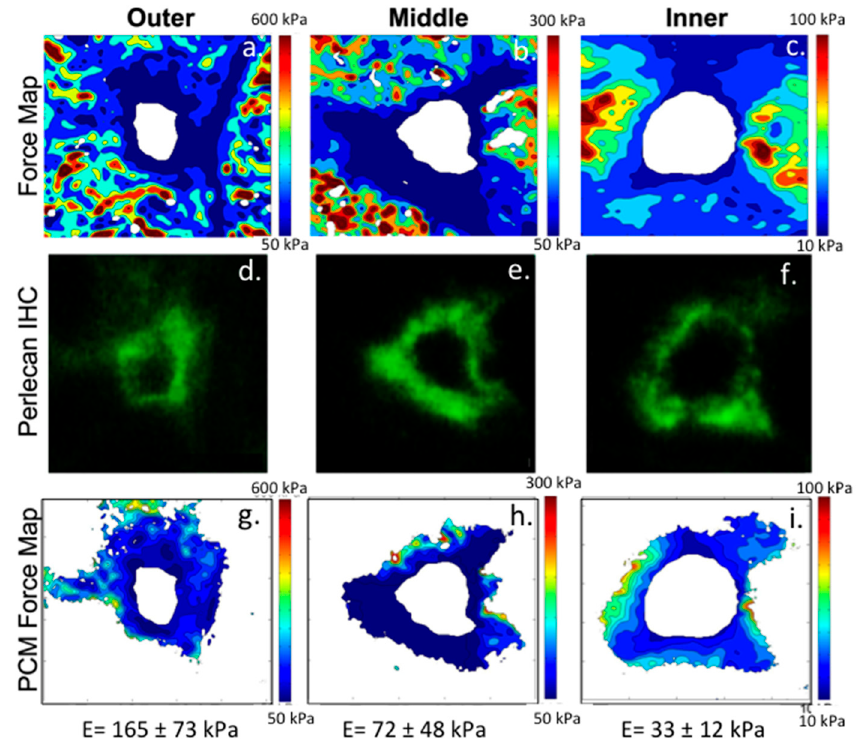
Figure 11. Integration of AFM force maps ( a – c ) and fluorescence immunolabeling of perlecan in the meniscus ( d – f ). To determine the micromechanical properties of the pericellular matrix (PCM) within the meniscus, meniscal tissue samples were cryosectioned and immunofluorescently labeled for perlecan, which has been shown previously to be localized to this matrix compartment within the meniscus [114]. PCM and ECM properties were evaluated as described previously [43] with PCM sites identified by positive pericellular labeling for perlecan and ECM sites identified by a lack of perlecan staining. Force maps of 20 × 20 µ m pericellular regions within each meniscus region ( top row) were integrated with fluorescent perlecan staining ( middle row) to define PCM